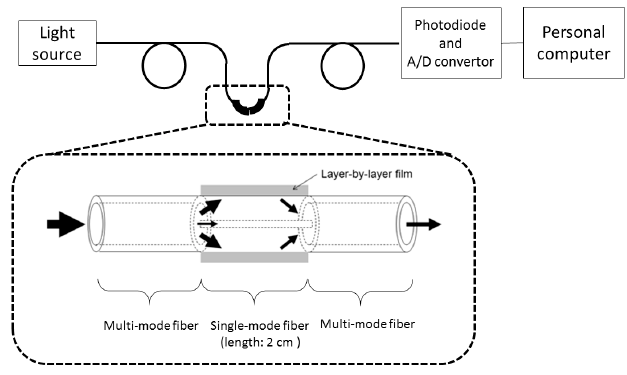
Figure 1. Schematic diagram of the measurement system and sensor